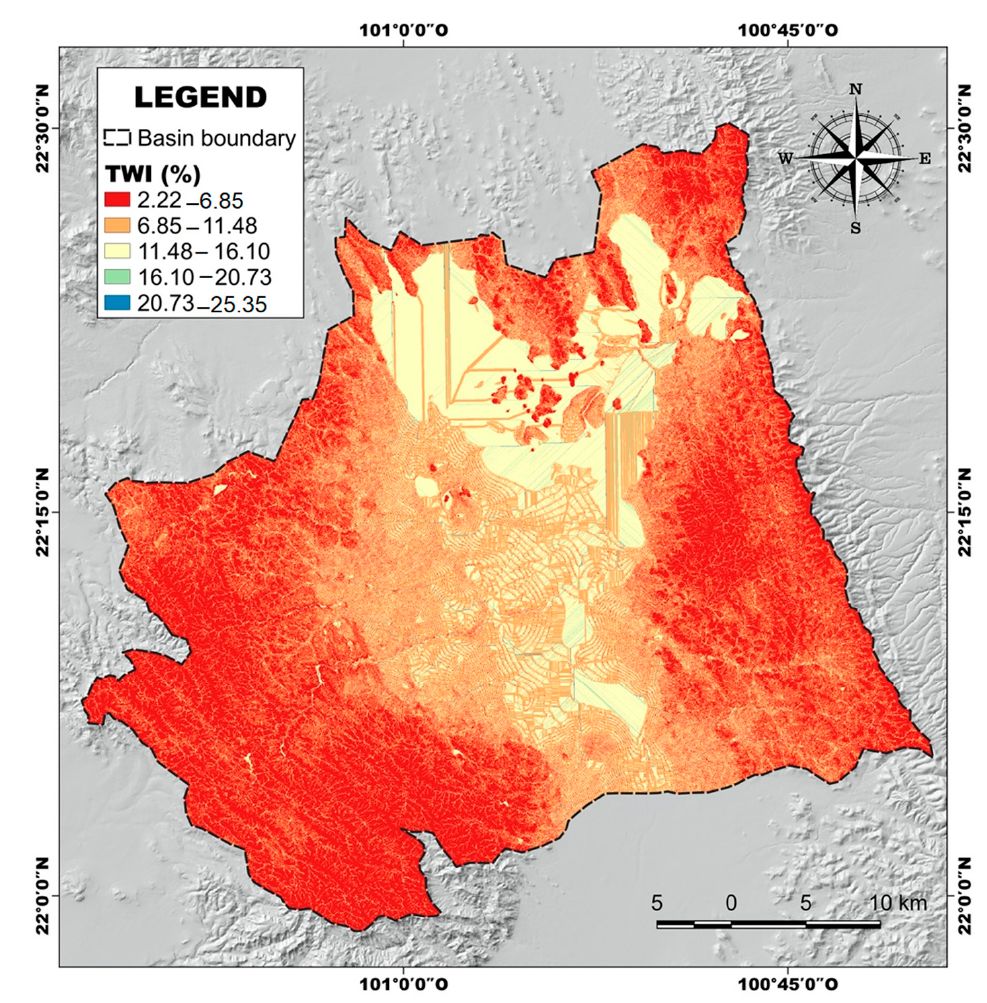
Figure 10. Topographic Wetness Index of the San Luis Potosi Basin.